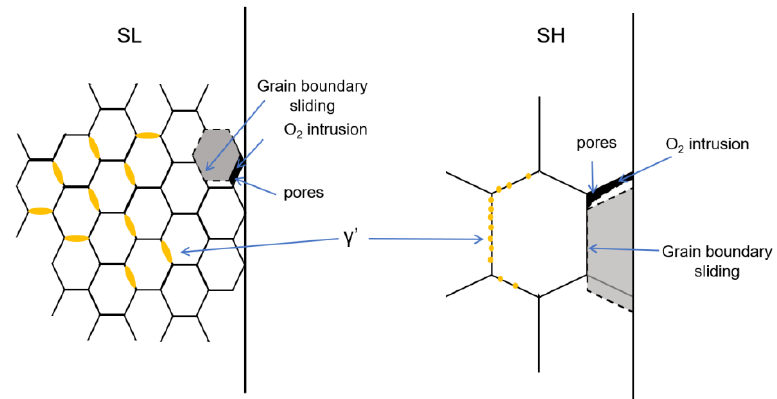
Figure 13. Schematic illustration of heat treatment to mechanical performance of superalloy at high